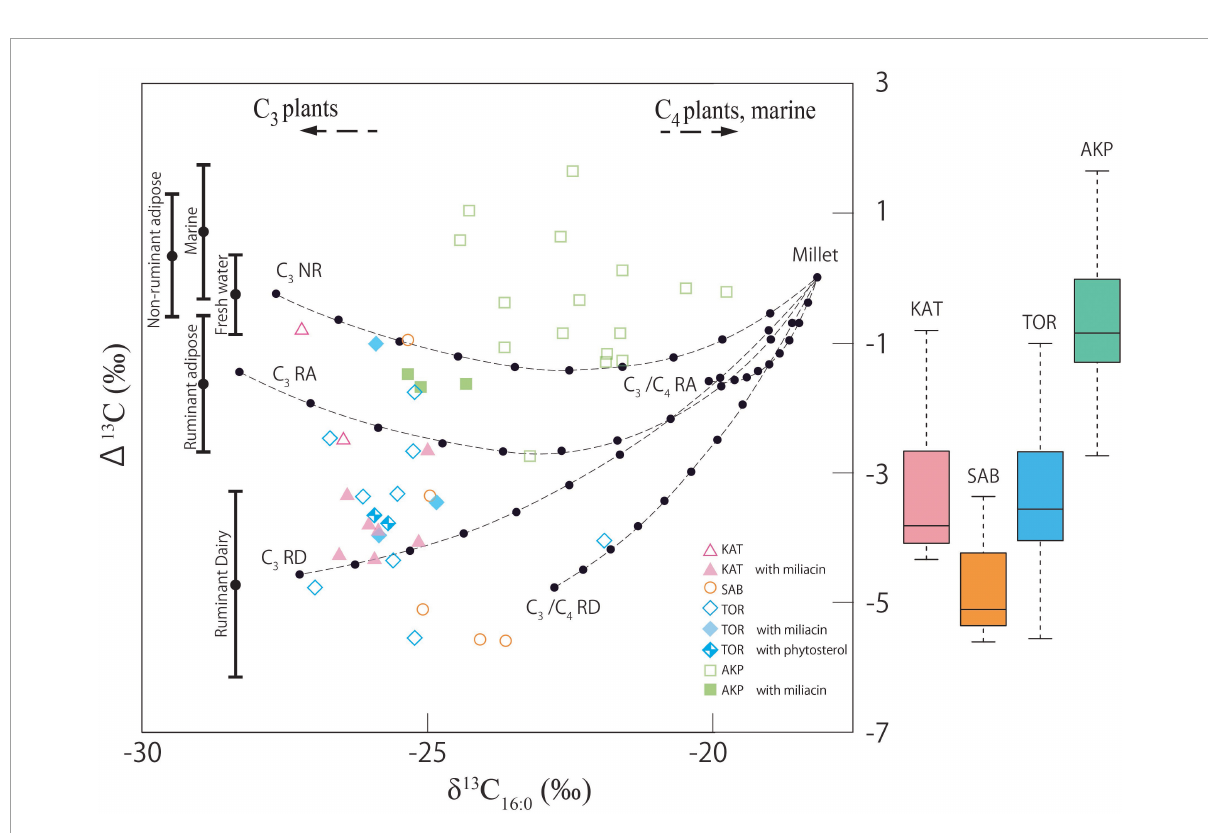
FIGURE5 Plot of the offset between the δ 13 C values of stearic and palmitic acids ( (cid:49) 13 C value) against the δ 13 C value of the palmitic acid. Reference ranges show quartile ranges based on data from existing studies (Dudd and Evershed, 1998; Spangenberg et al., 2006, 2010; Gregg et al., 2009; Outram et al., 2009; Dunne et al., 2012; Spiteri, 2012; Craig et al., 2013; Horiuchi et al., 2015; Miyata et al., 2015; Taché and Craig, 2015; Choy et al., 2016; Heron et al., 2016; Lucquin et al., 2016; Courel et al., 2020; Pääkkönen et al., 2020; Taché et al., 2021). The hypothetical mixing curves (Taché et al., 2021) are compared with the plots to verify when the offset values are large due to the mixing of